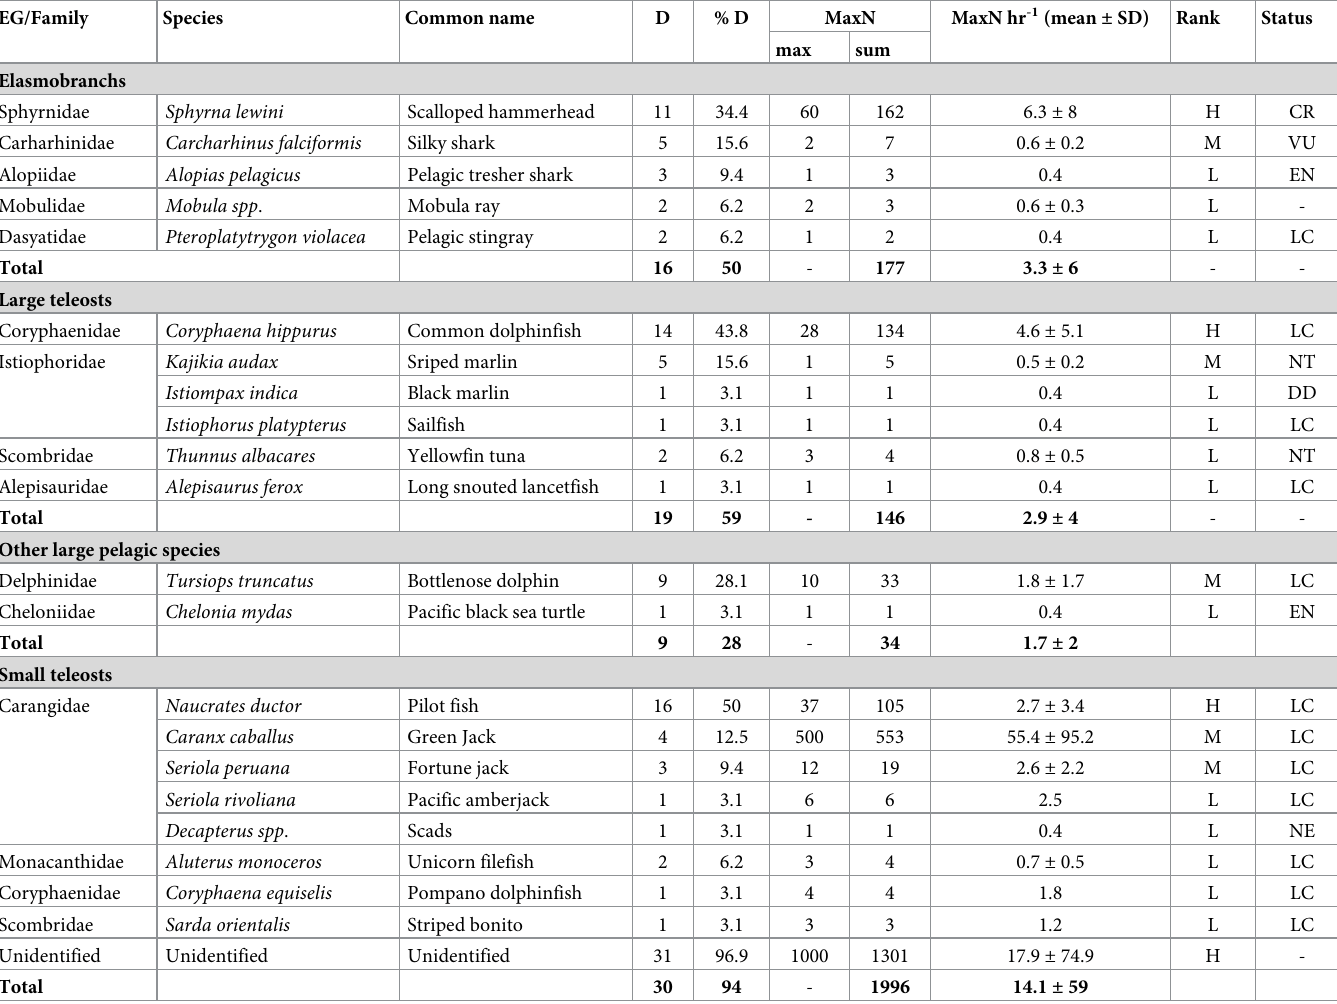
Table 2. Summary of occurrence, relative abundance (MaxN and MaxN hr -1 ) and conservation status of all species classified by groups recorded on baited remote underwater video stations (BRUVS) along Cocos Ridge